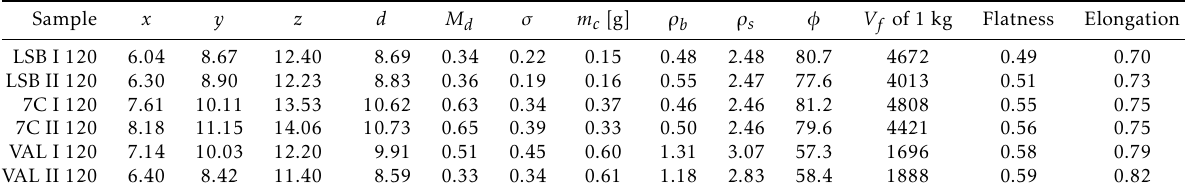
Table 4 – Shape, size, and density of post-experimental samples for 120-minute experiments with 2 kg starting load. Calliper measurements, mass, density and shape factors for large clasts following tumbling experiments with 2 kg starting mass and 120 minutes duration. Porosity ( φ ) is calculated using the average volume, M ) and pore-free density ( ρ ). The volume (V ) of 1 kg of sample was calculated based on a solid packing density ( ρ b s f fraction of